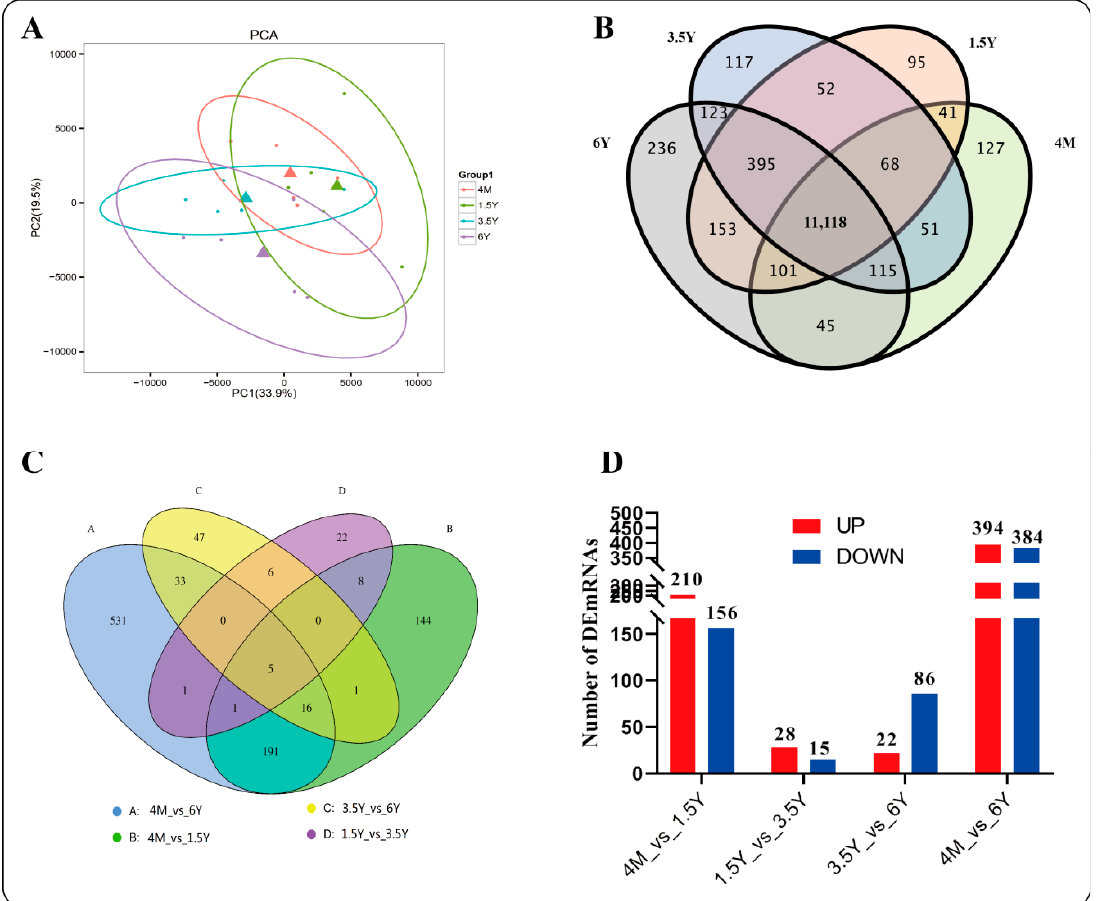
Figure 4. Differential mRNA analysis. ( A ): PCoA diagram; ( B ): Venn map of expressed genes; ( C ): differential gene Venn map; ( D ): up-down differential gene analysis. 4M: 4 months; 1.5Y: 1.5 years; 3.5Y: 3.5 years; 6Y: 6 years.